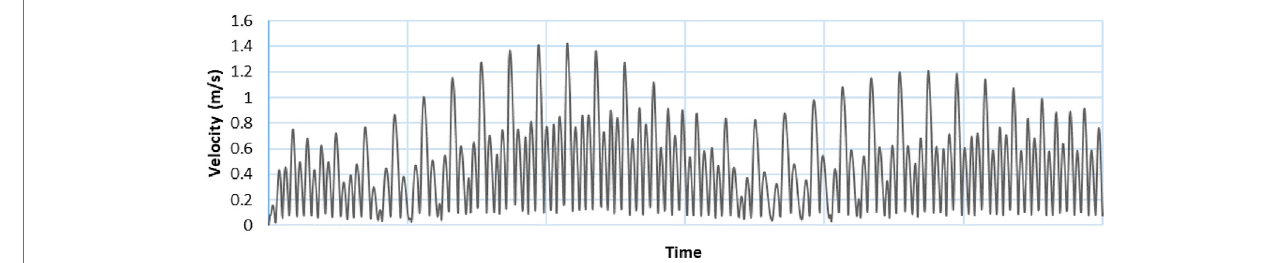
FIGURE 11 | Velocity pro fi le of Singapore location.